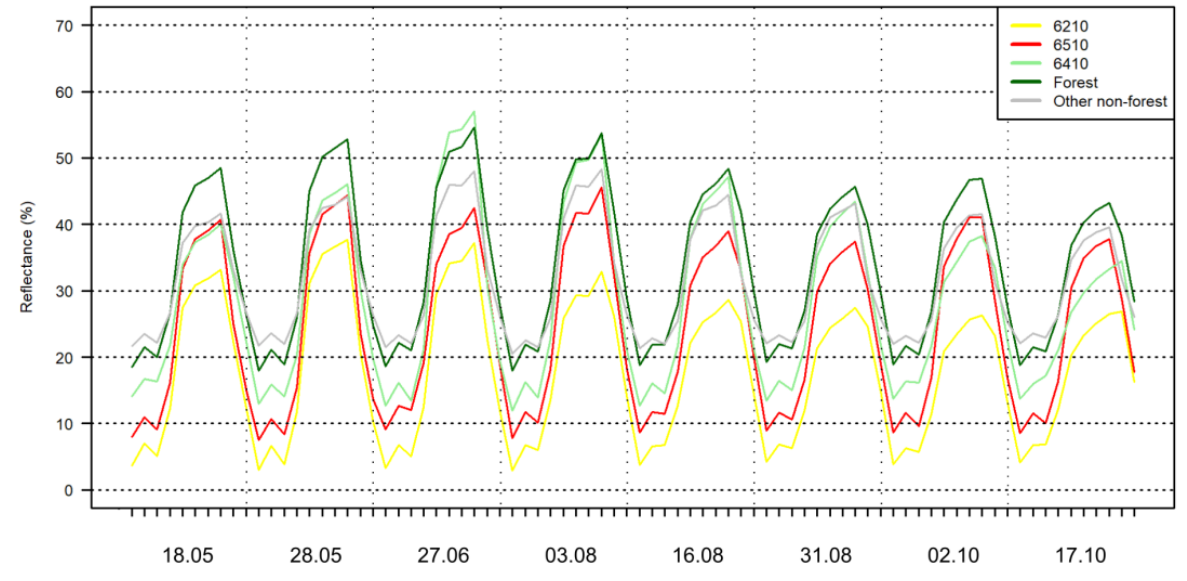
Figure 2. Mean reflectance curves extracted for each class from the spectro-temporal dataset. Curves present spectral band data across acquisition times with single-unit spacing, representing spectro- temporal data fed into classification algorithms. Curves offset for clarity (5 percentage points in reflectance).